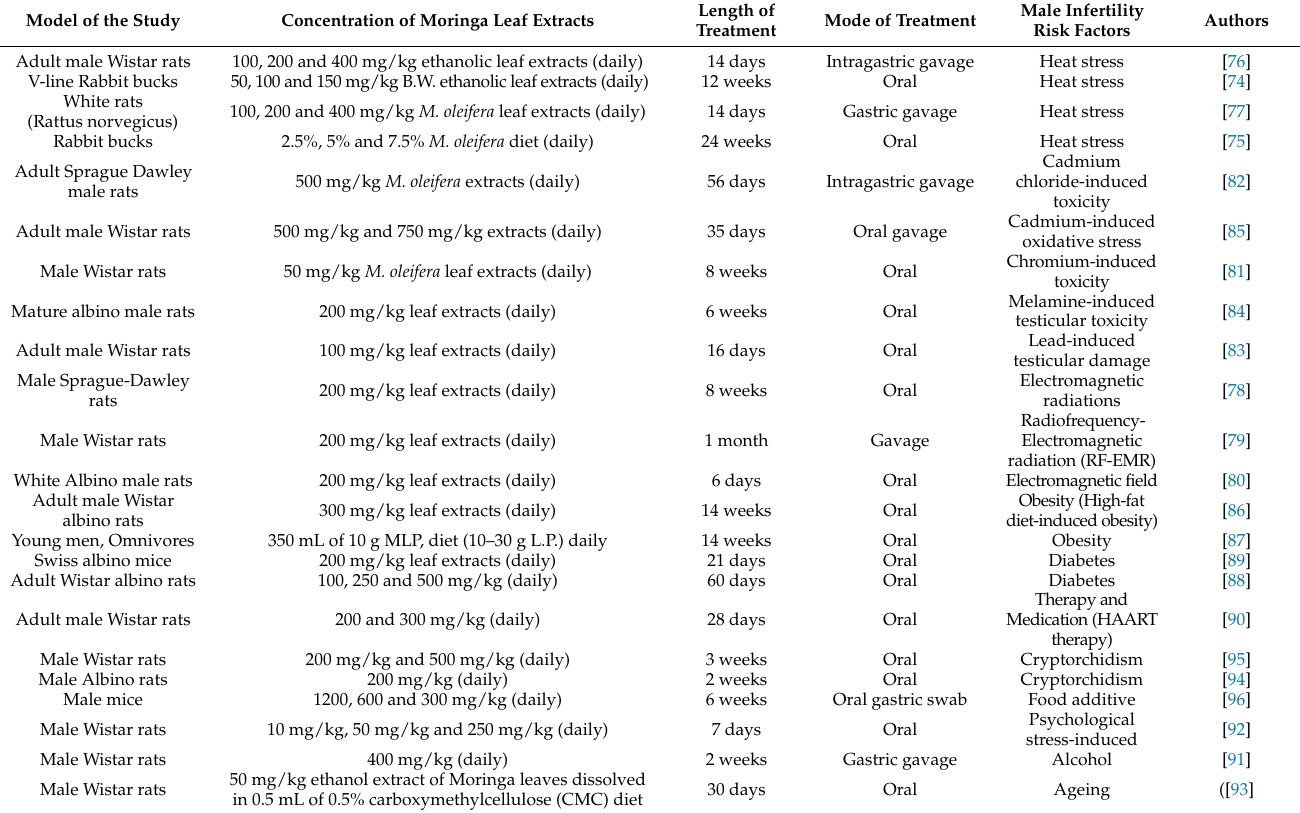
Table 2. Male infertility risk factors studied, M. oleifera extract, model of the study, length and mode of